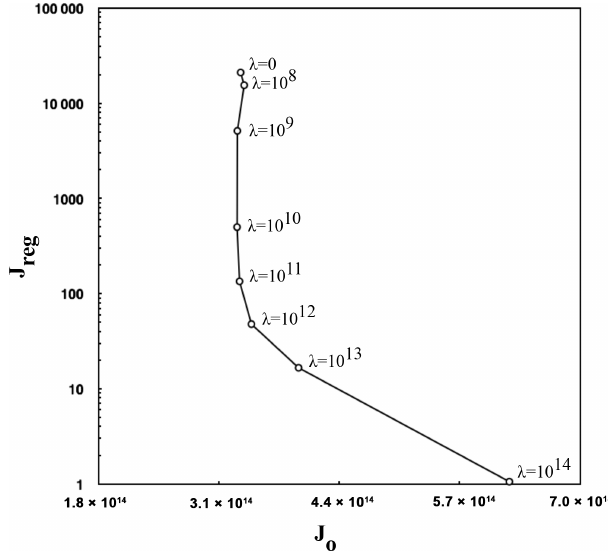
Figure 2. L curve obtained with the control inverse method: cost function J o and Tikhonov regularization term J reg , parameterized by the regularization parameter λ (which determines the contribu- tion of J reg to the total cost function, J tot = J o + λJ reg